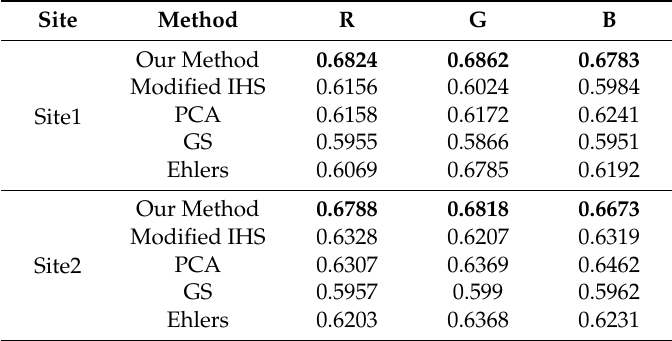
Table 4. Entropy between the fused KOMPSAT-5 images and the criterion Landsat-8 OLI image.